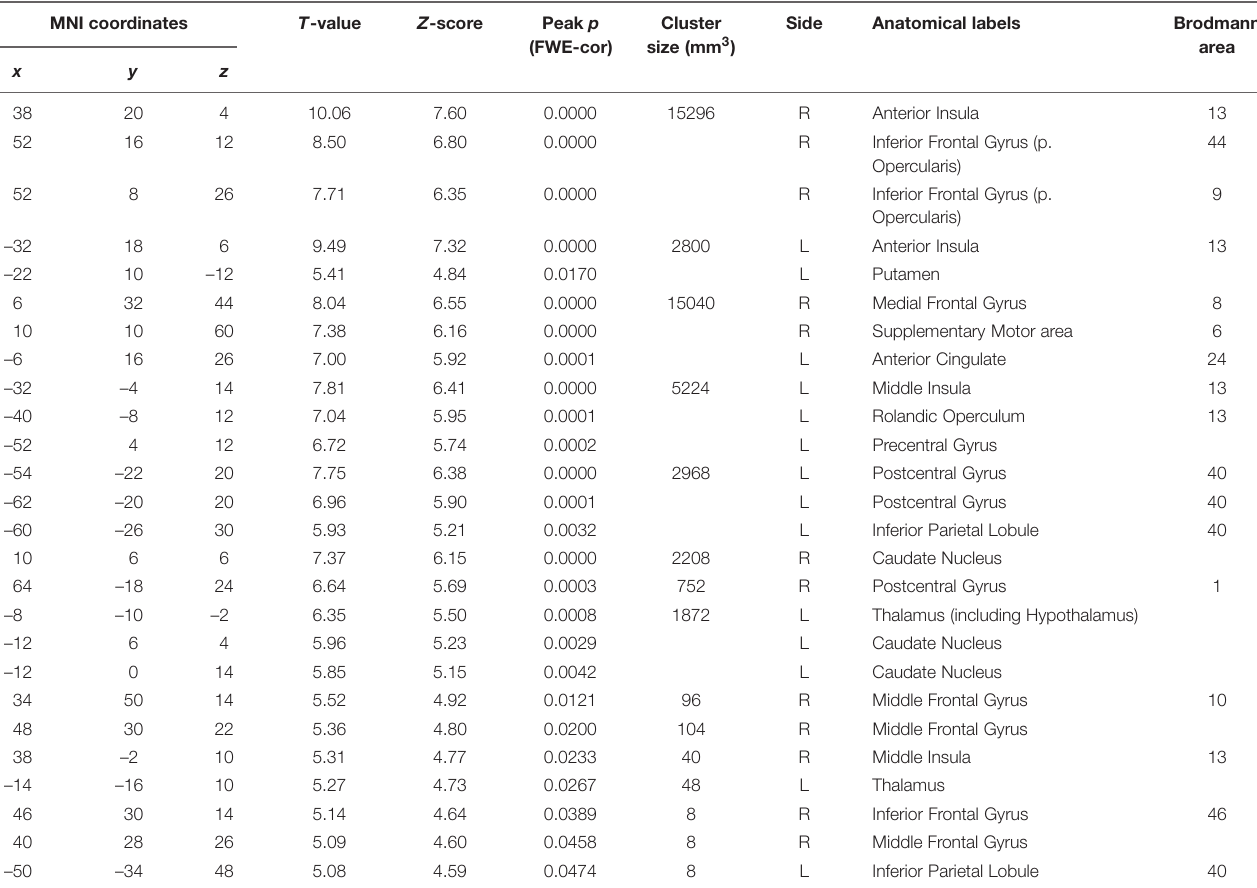
TABLE 2 | The peak coordinates displayed significant responses by the comparison